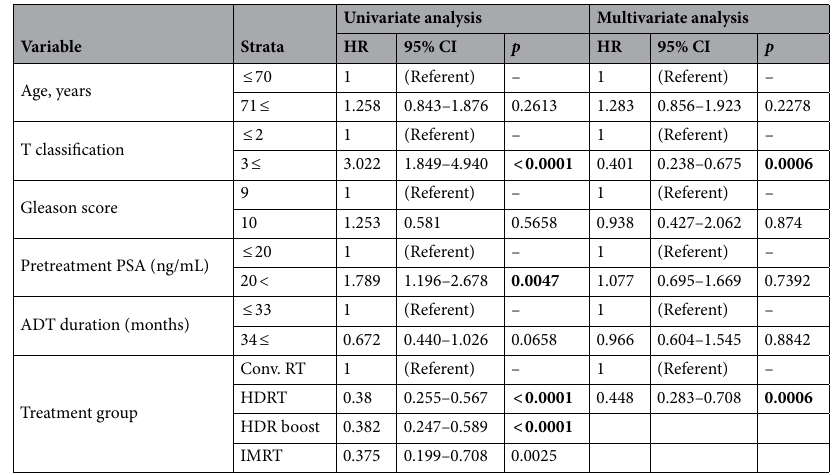
Table 3. Uni- and multi-variate analysis for biochemical control rate using Cox proportional hazards model. CI confidence interval, HR hazard ratio, NA not available, HDR boost high dose rate brachytherapy boost, EBRT external beam radiotherpay, Conv RT conventional radiotherapy. Bold values indicate statistically significance.